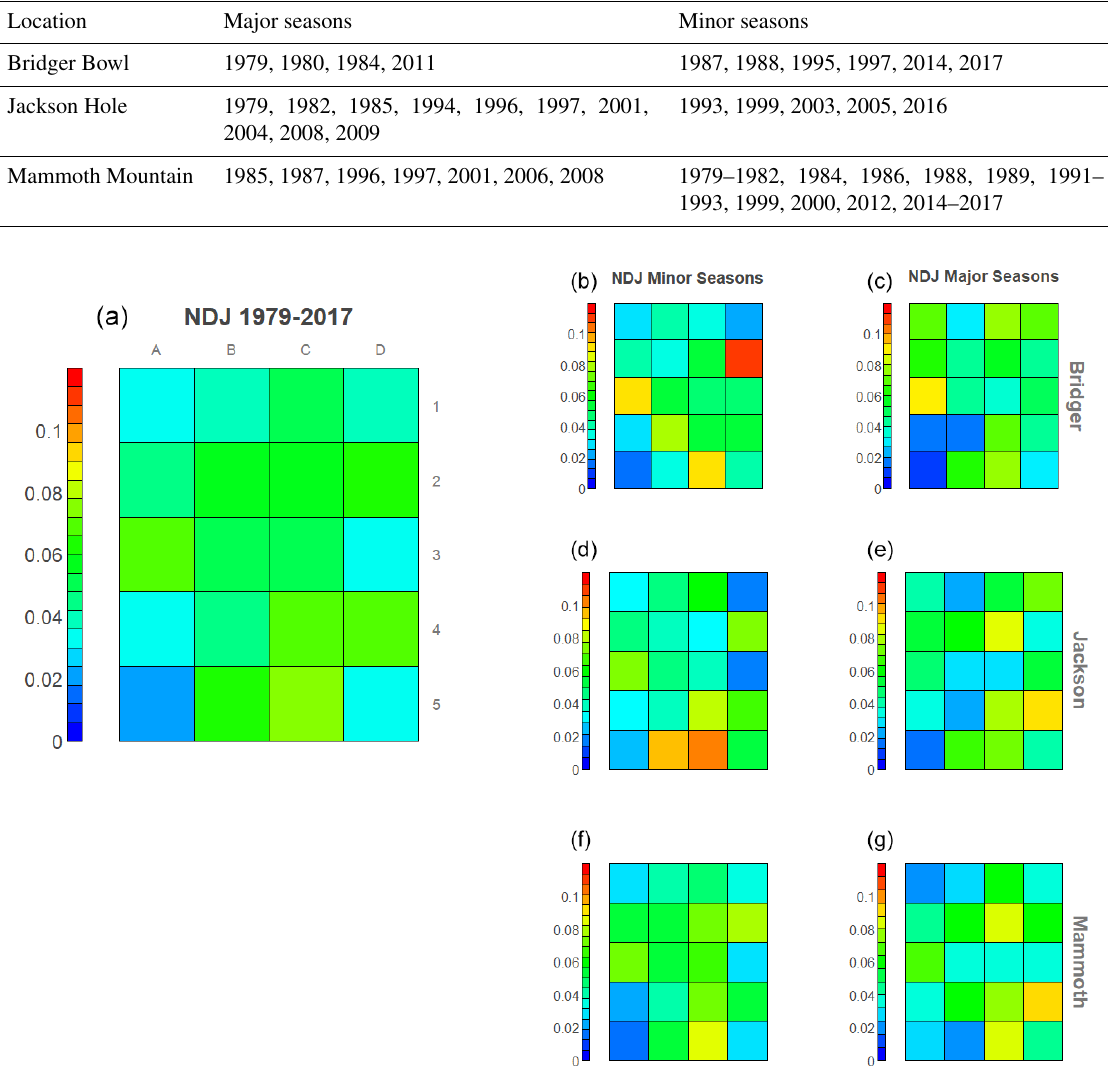
Figure 5. Relative frequencies for each synoptic type from November–January for the entire study period (a) , over all minor seasons (b, d, f) , and all major seasons (c, e, g) . Heat maps are given for Bridger Bowl (b, c) , Jackson (d, e) , and Mammoth Mountain (f, g) . Frequencies are calculated by summing counts of days assigned to each synoptic type over all major (minor) seasons and dividing by total number of days for all major (minor)